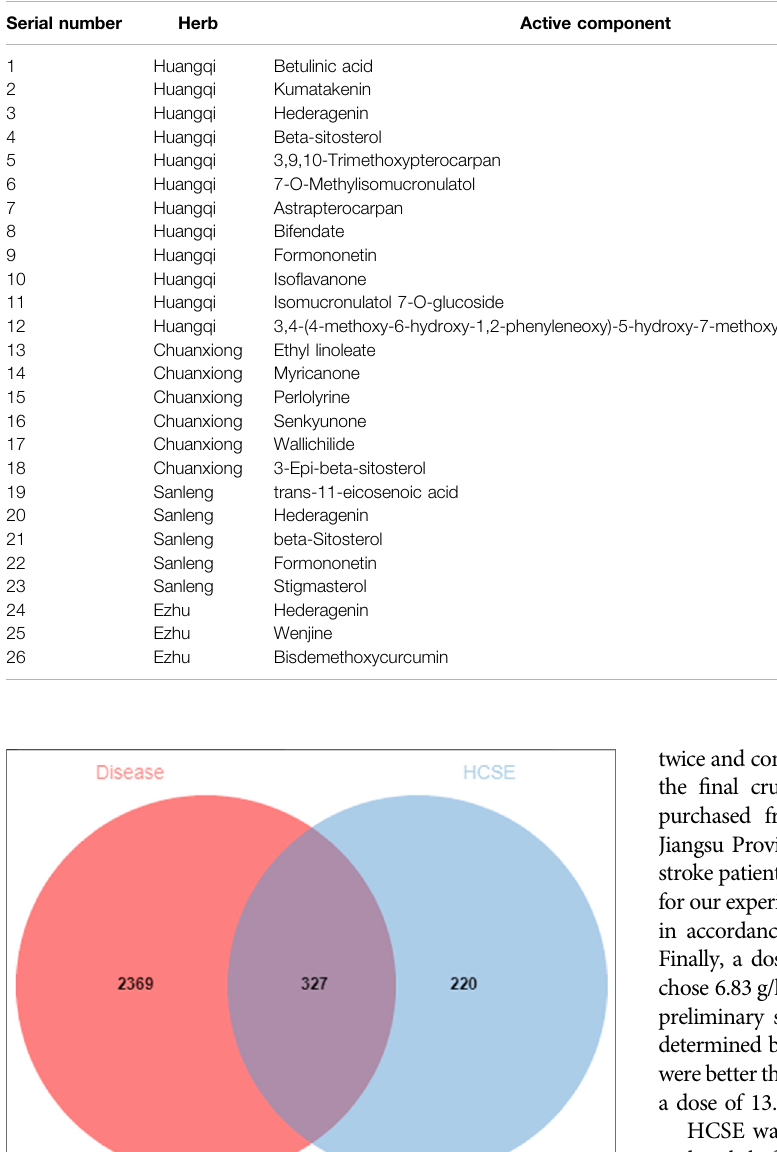
TABLE 3 | Active compounds contained in the new formulation.